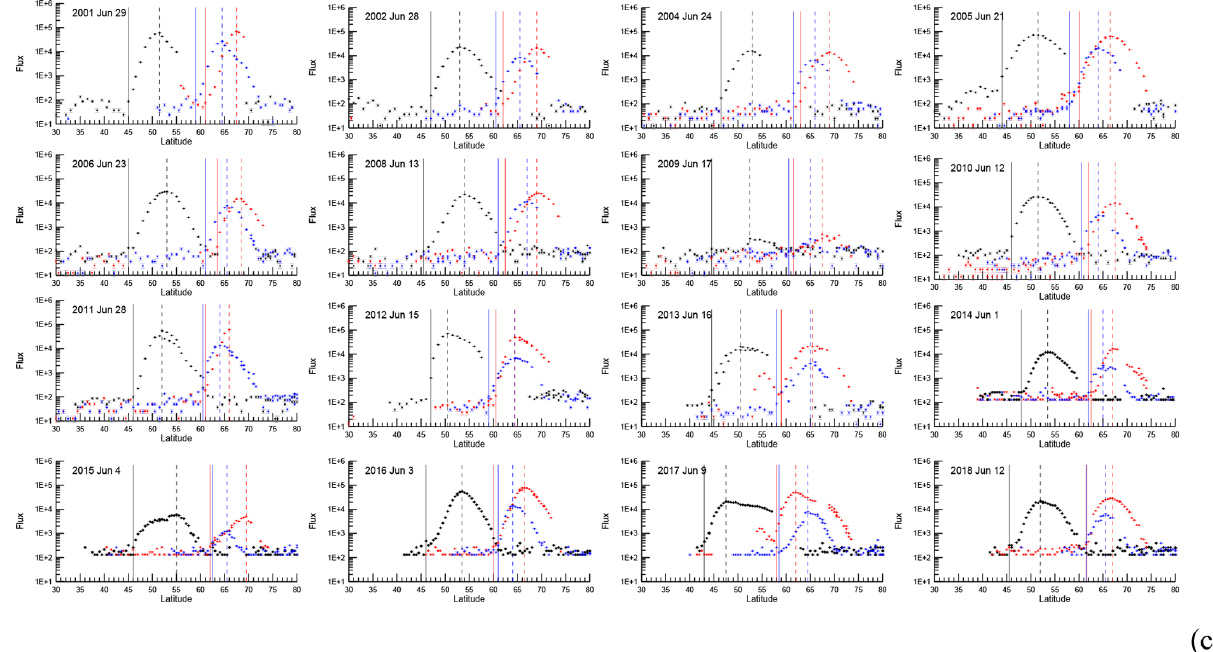
Figure 3. Latitudinal profiles of electron fluxes with pitch angles of ∼ 90 ◦ observed by POES satellites during quiet days in different years at a height of ∼ 850km in the vicinity of local noon at longitudes around 100 ◦ E (red circles), 0 ◦ E (blue crosses) and 80 ◦ W (black diamonds) for various energy channels: (a) >30, (b) >100 and (c) >300keV. Vertical dashed and solid lines indicate latitudes of the maximum and inner edge of the outer radiation belt, respectively.